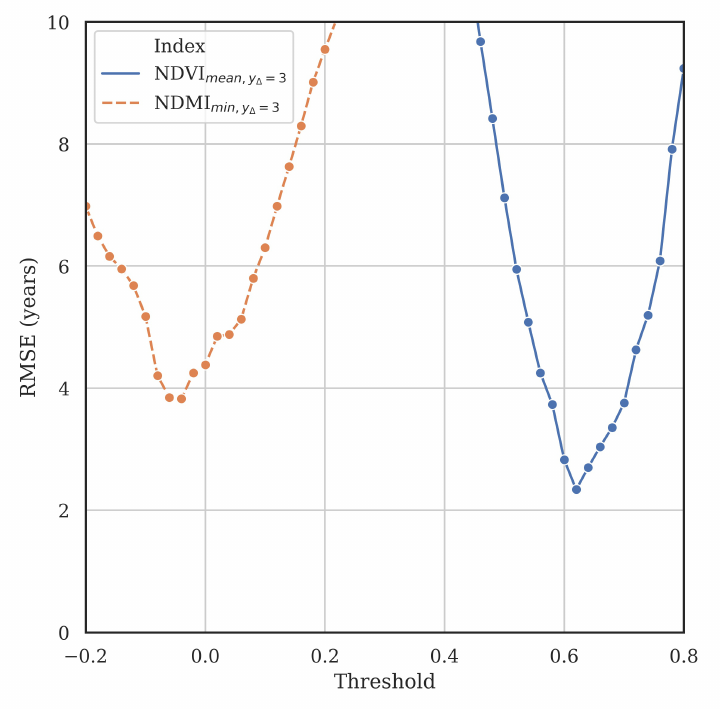
Figure 4. Search for optimal plant-year prediction algorithm by minimizing prediction error. Two of the 80 parameter sets are shown, including the best set (NDVI mean , y ∆ = 3 with a threshold of 0.62).